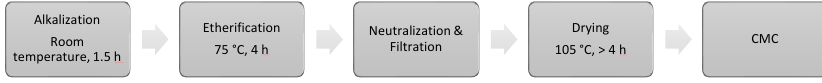
Figure 1. The process flow chart of CMC film synthesis.